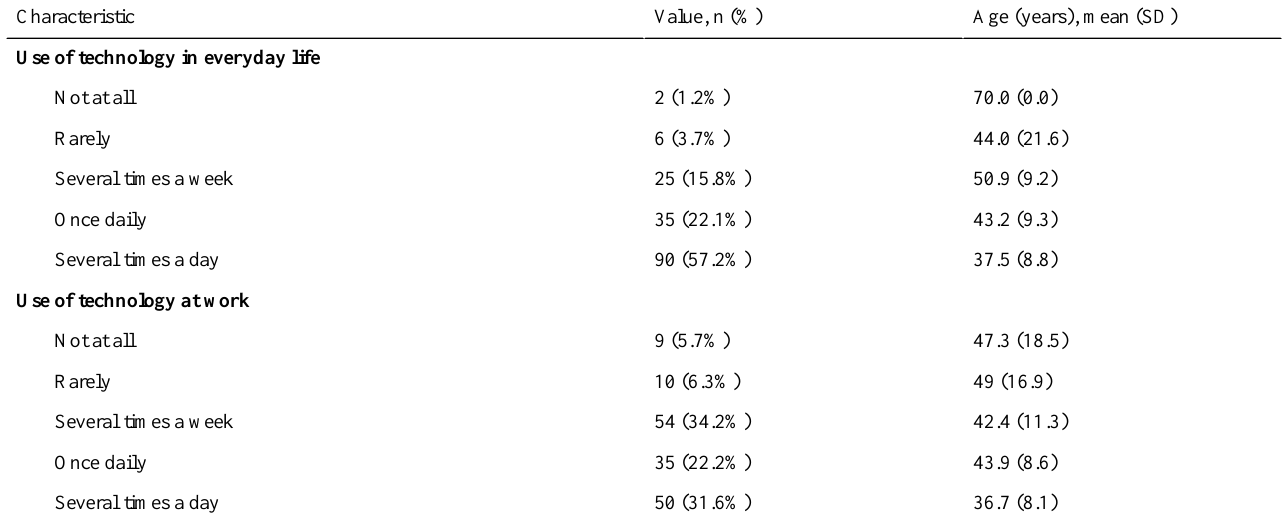
Table 1. Technology use (N=158).